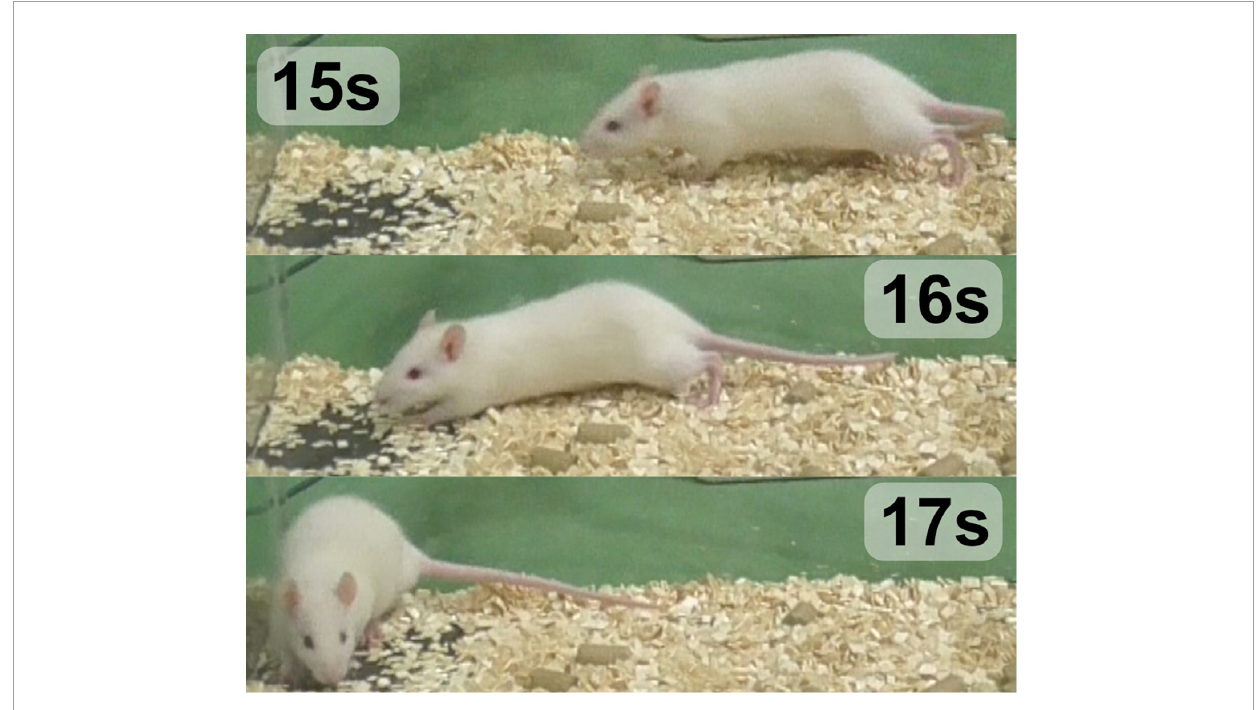
FIGURE11 Time-lapse of the rat at the 15–17 s mark, displaying the rat’s walking behavior.